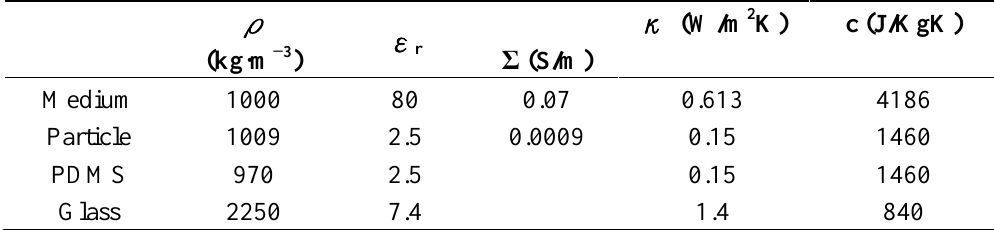
Table 1 . Physics properties of different materials.